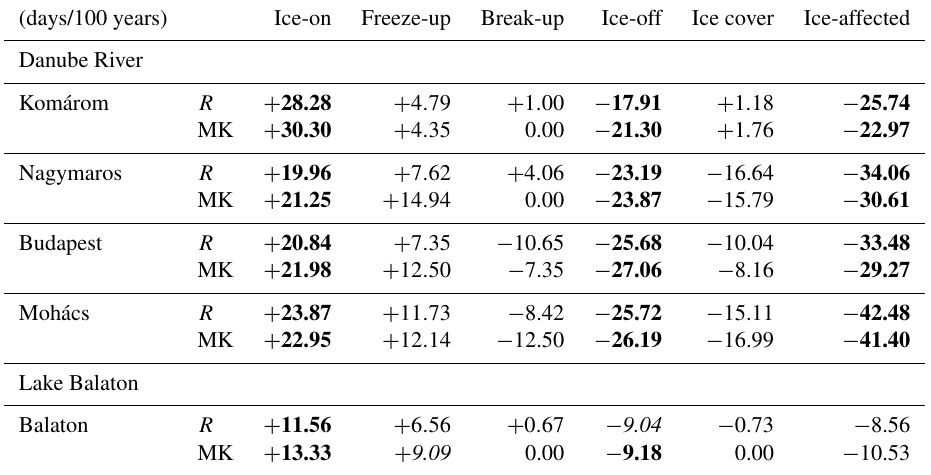
Table 4. Changes in the ice regime of the River Danube and Lake Balaton from 1885 to 2017. (Values with p < 0 . 05 are shown in bold, and p < 0 . 10 are given in italics; R : trend calculated by linear regression; MK: trend calculated by a Mann–Kendall test).